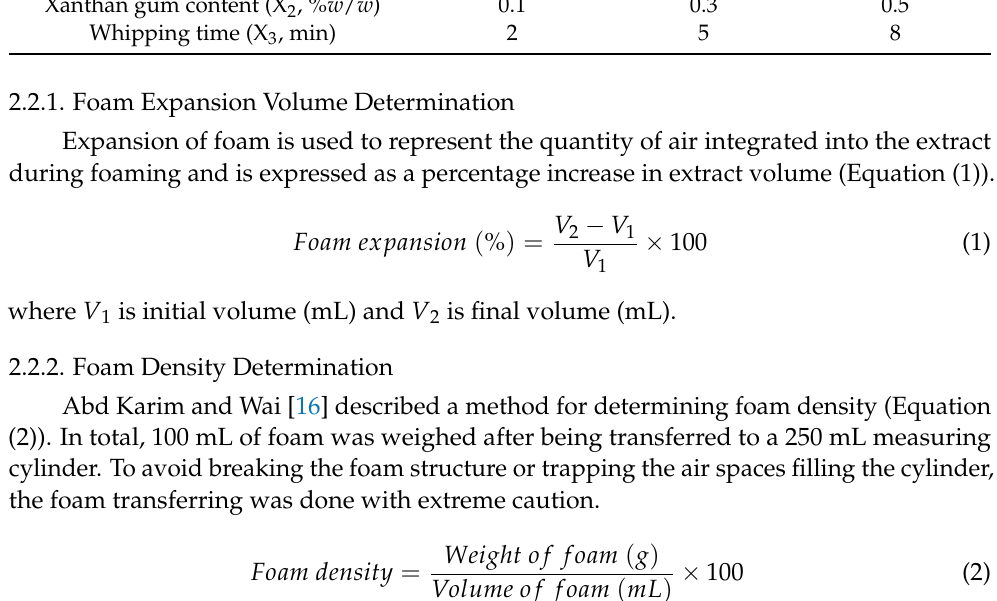
Table 1. Factors level of this study. Variables